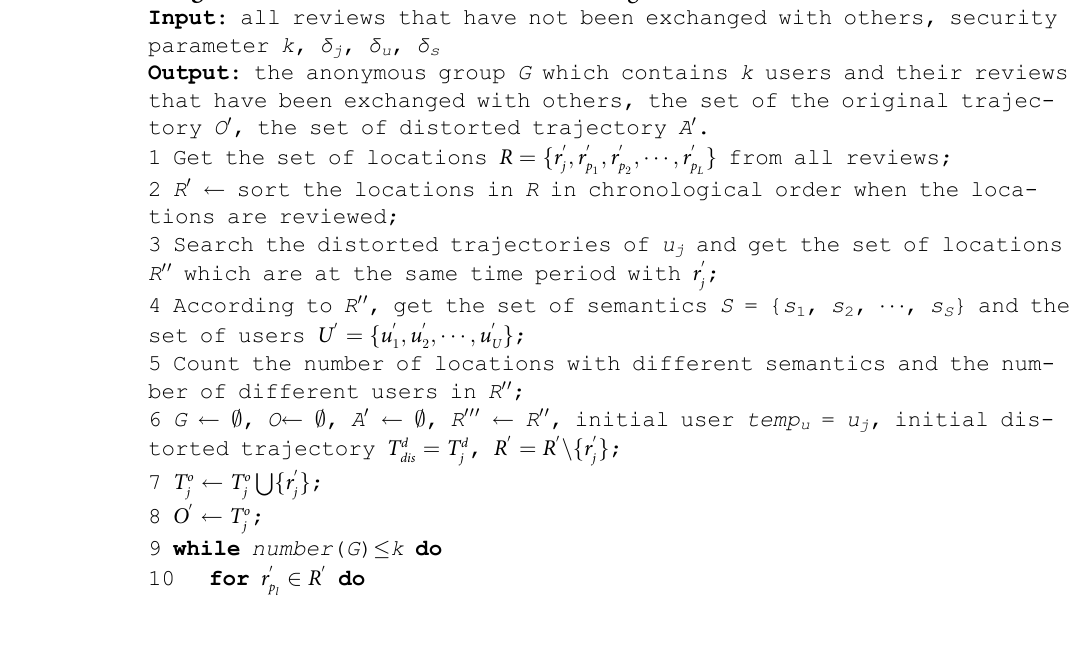
Algorithm 3 : User Selection to Resist SLSA